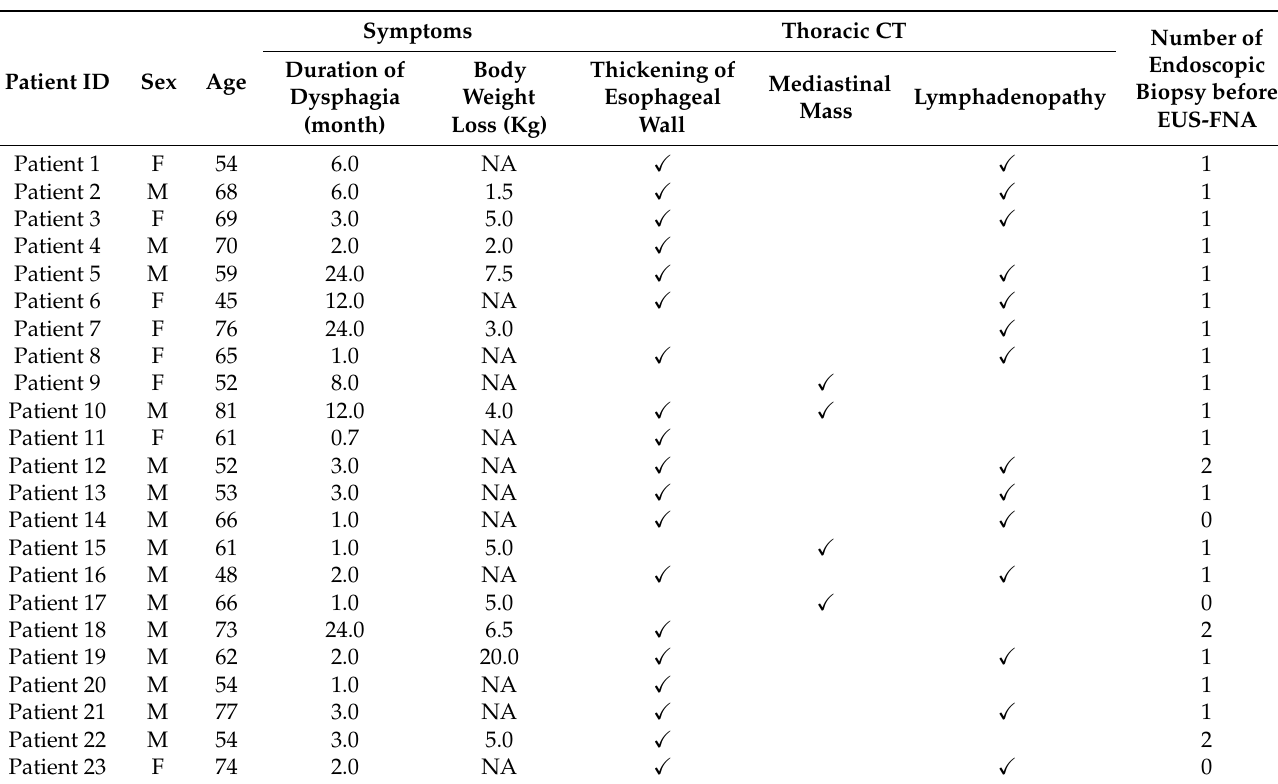
Table 1. General characteristics of